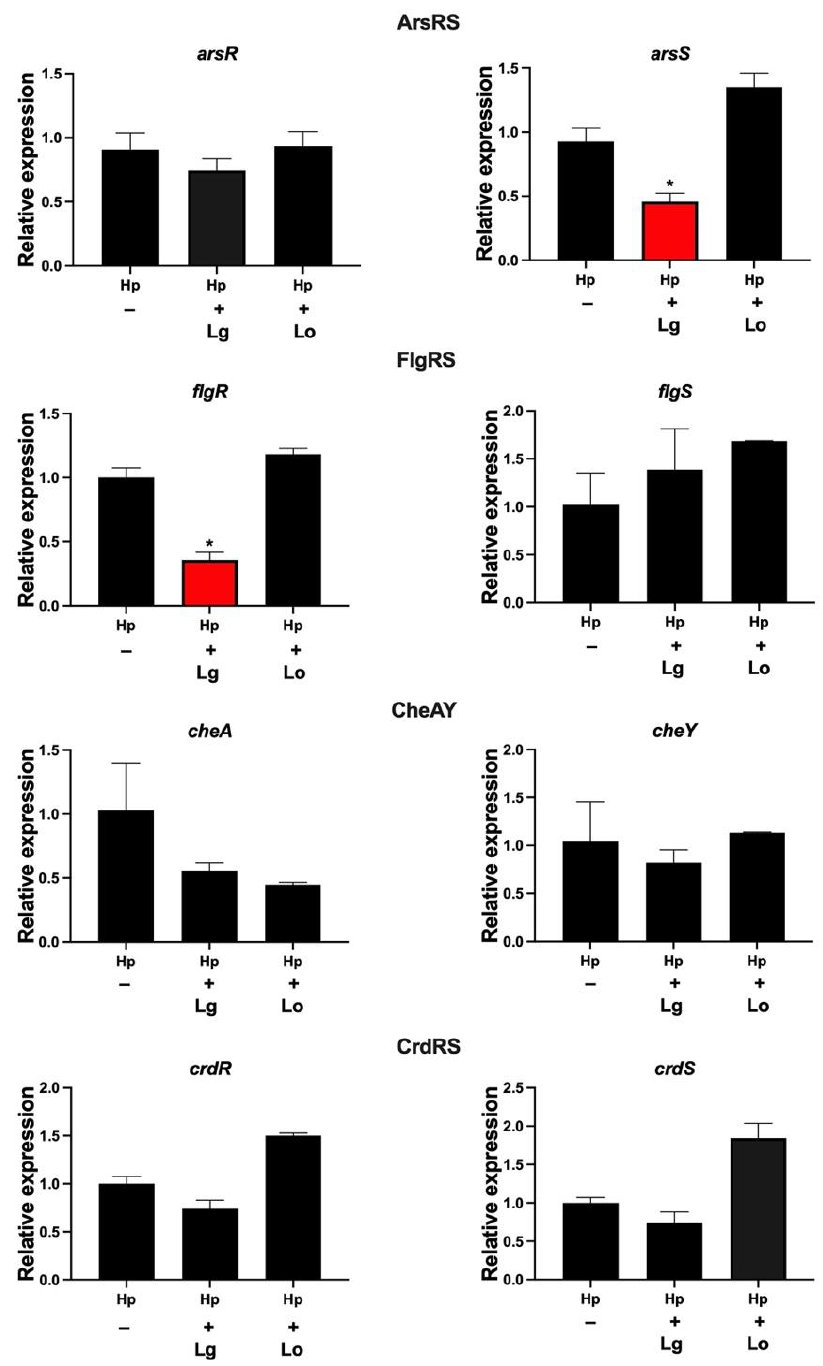
Figure 1. L. gasseri CM affects the gene expression of arsS and flgA. Gene expression of H. pylori (Hp) two-component systems analyzed by qPCR after incubation for 2 h in CM from L. gasseri (1) or L. oris (Lo). Target mRNA levels were normalized to those of the housekeeping gene gyrB . Gene expression levels in the control were set to 1. Data are presented as the means and standard deviation of duplicate samples and are average of three independent experiments. * p < 0.05.